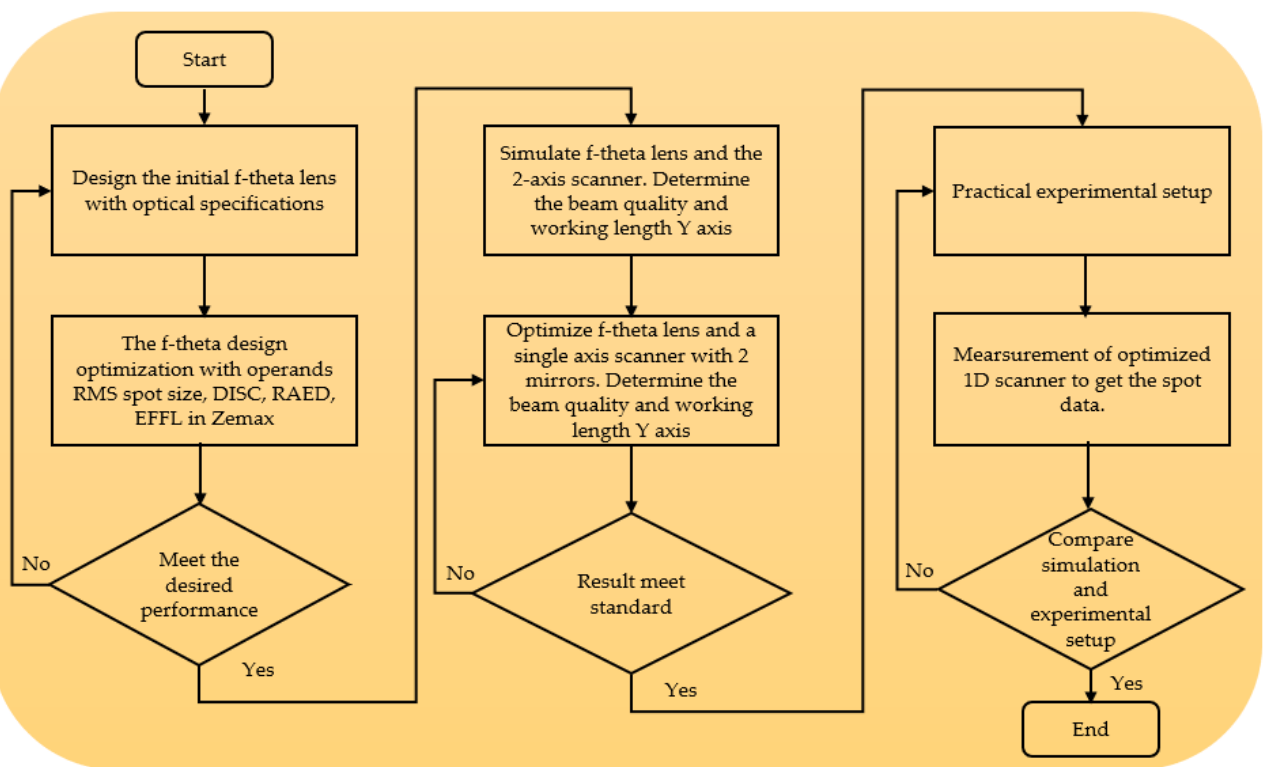
Figure 4. The workflow of simulating a single-axis scanner using two galvanometers in combination with the f-theta lens in simulation and experimental